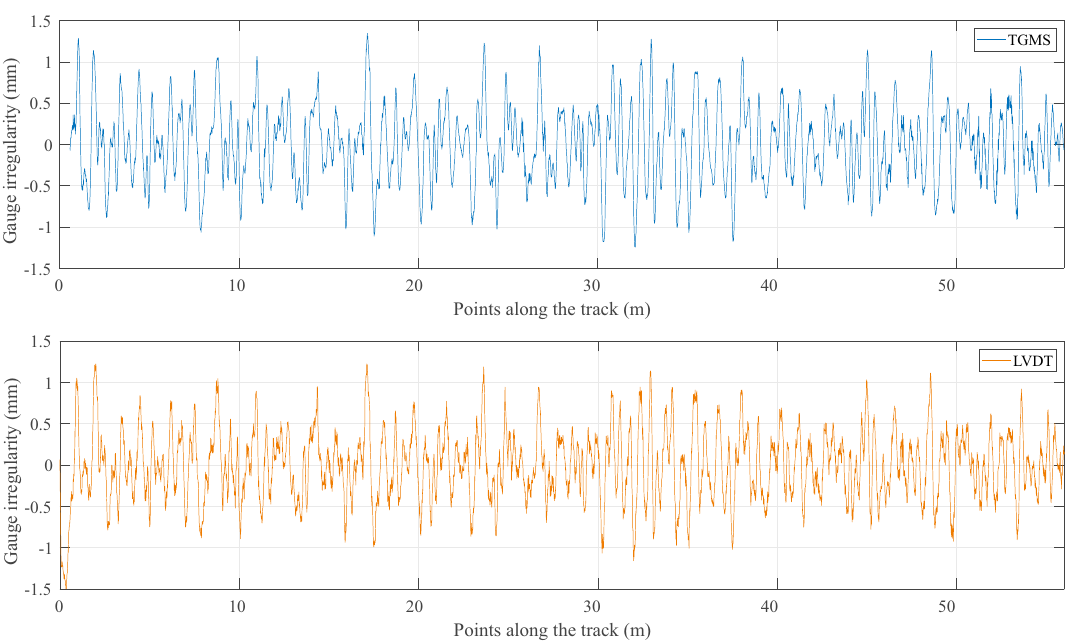
Figure 17. Measurements of gauge variation.